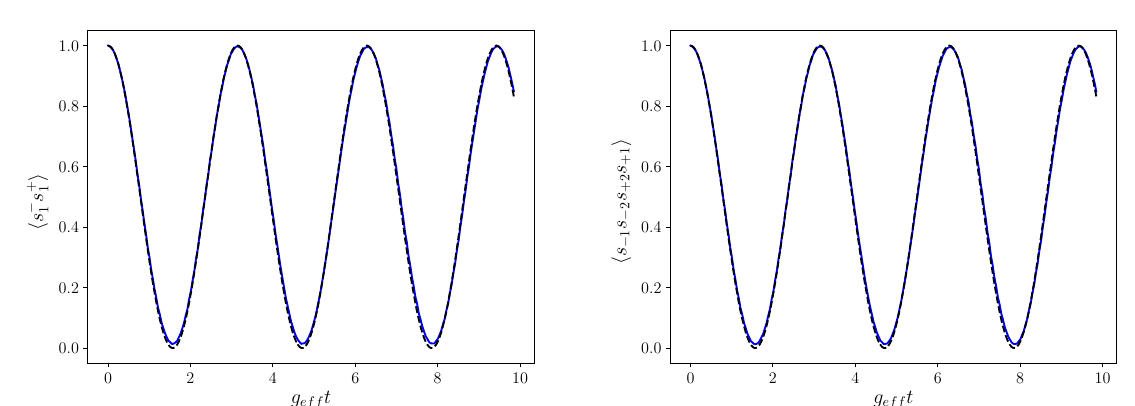
s 2 s + 2 s + 1 (cid:105) (below) for the initial non-excited atoms and 1 s + 1 (cid:105) (above) and (cid:104) s 1 s (cid:104) − − − 0 1 ,0 2 ; ν = ˜ ω 1 + ˜ ω 2 , ω 2 = 3 ω 1 , ω c = ω 1 + ω 2 with ω 1 = 10, and g 0 = g 1 = g 2 = 1; the | (cid:105)